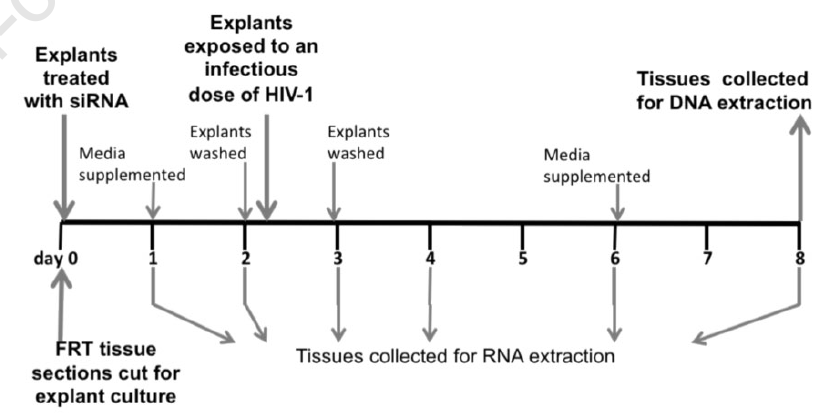
Figure 1. Timeline of the experimental protocols using human female reproductive tract explants. Samples of female reproductive tract tissues were received, dissected, and placed into culture on day 0, the same day they were transfected with nanoparticles containing siRNA. On day 2, the explants were thoroughly washed to remove residual siRNA nanoparticles, and some sections were exposed to cell-free HIV-1BaL. On day 3, the HIV- exposed explants were again thoroughly washed to remove any unincorporated HIV-1. CCR5 and CD4 mRNA levels were measured on uninfected ectocervical explants on days 1, 2, 3, 4, 6, and 8, and only on days 3 and 6 in explants from endometrium and endo- cervix. HIV-1 DNA was measured on the HIV-1 exposed explant cultures on day